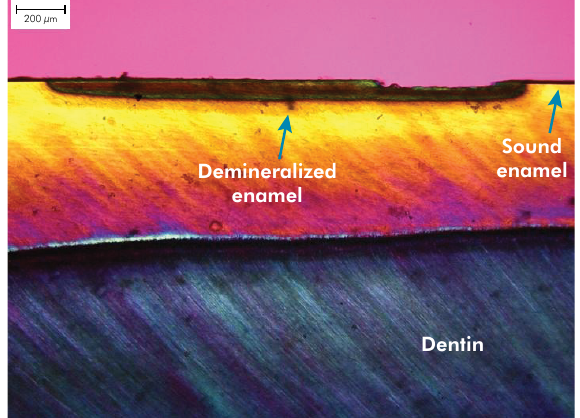
Figure 3. Enamel demineralization and lesion formation.